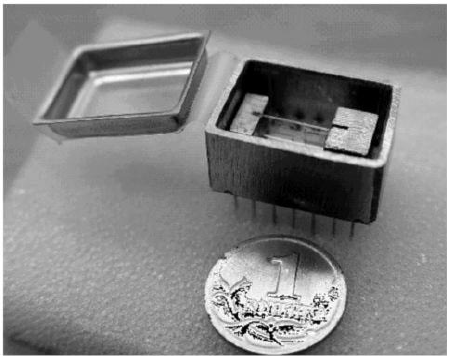
Figure 15. Experimental accelerometer design. Coin with approximately 1-cm diameter is shown for comparison.